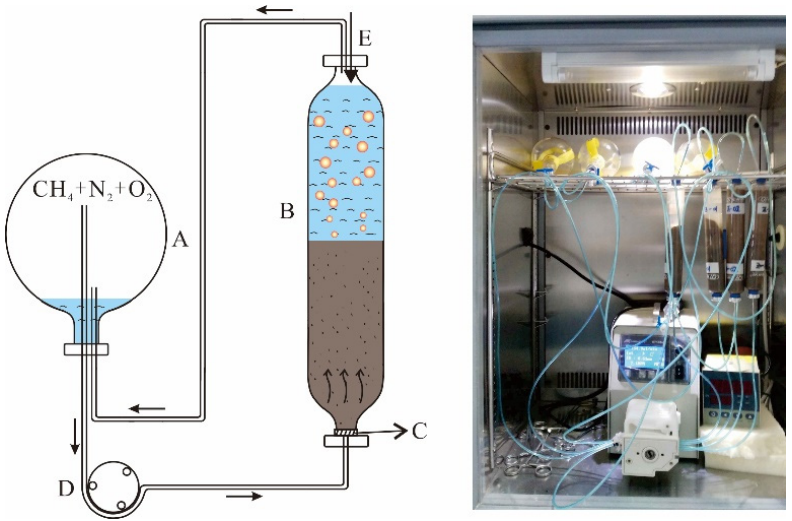
Figure 1. Experimental setup for incubation. Four treatments were run with the setup simultane- ously in this